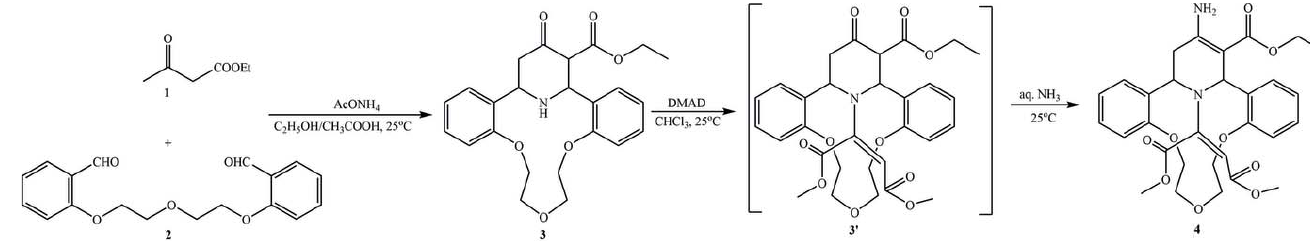
Figure 1 The modified reaction yielding the (cid:2) -amino- N -propylpiperidine 4